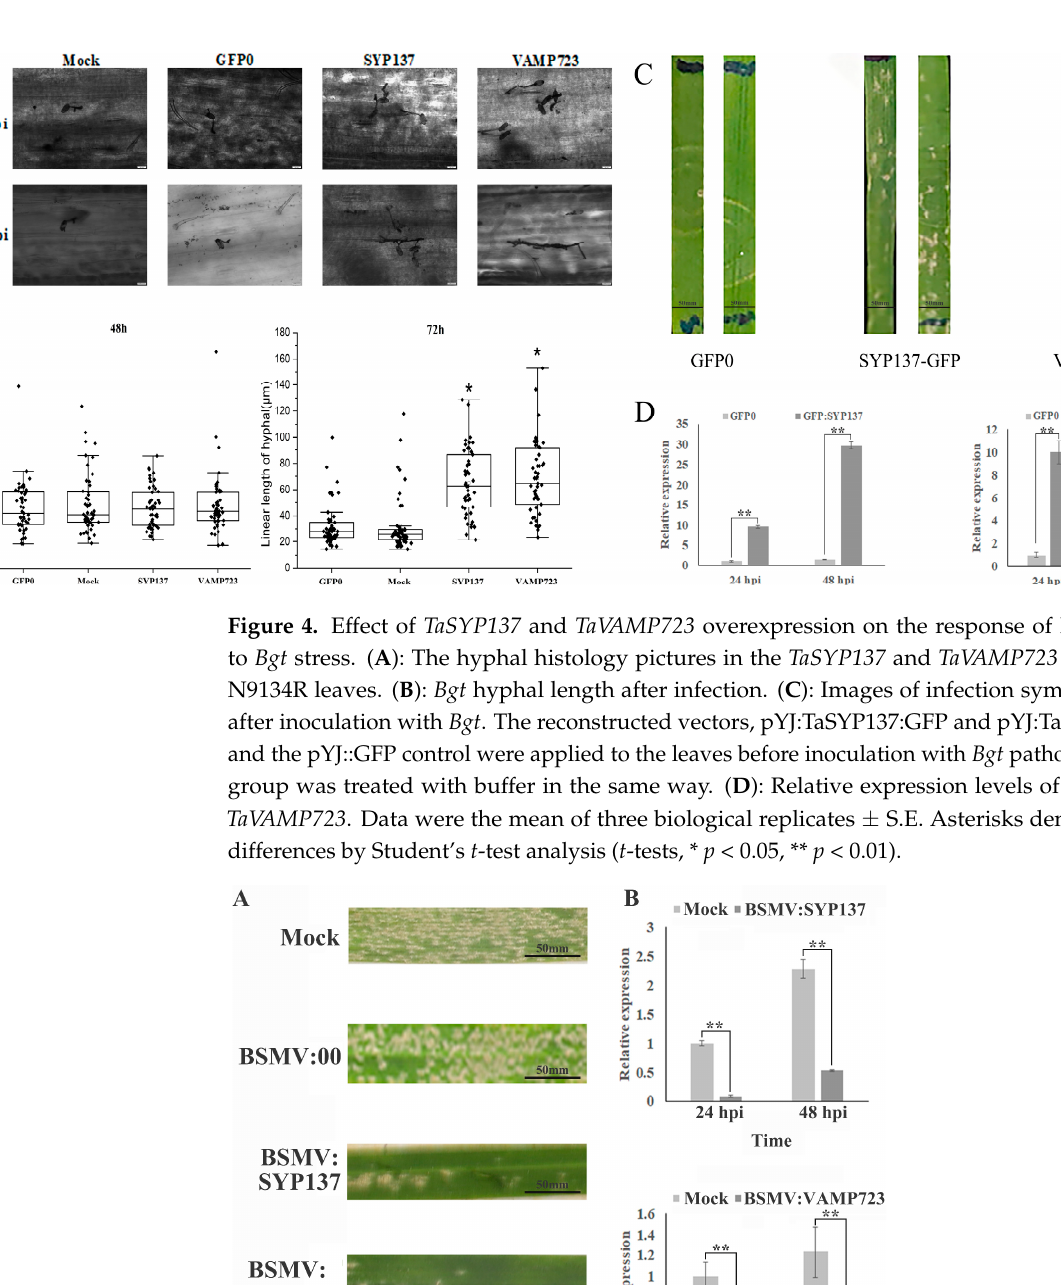
the overexpression of TaSYP137/TaVAMP723 inhibits wheat resistance to powdery mil- dew infection.